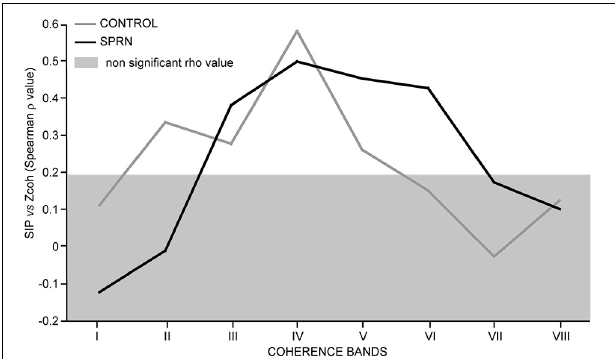
FIGURE 6 | Strength of covariation between the synchronous impulse probability (SIP) and the averaged coherence Z score (Spearman rho value, ordinate) as a function of the frequency range (bands I to VIII, abscissa); Rho values inside the light gray area are not significant; black and gray lines, SPRNP patient and healthy subjects, respectively.